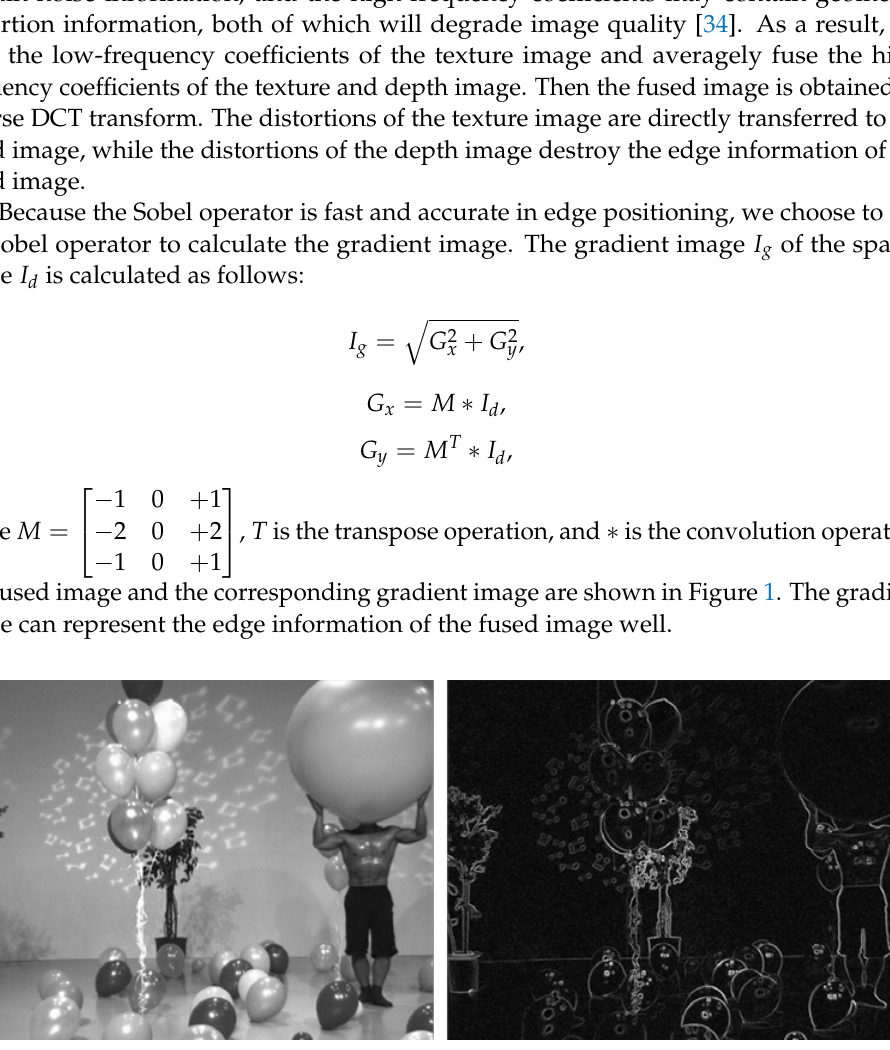
Figure 1. Fused image and corresponding gradient image.